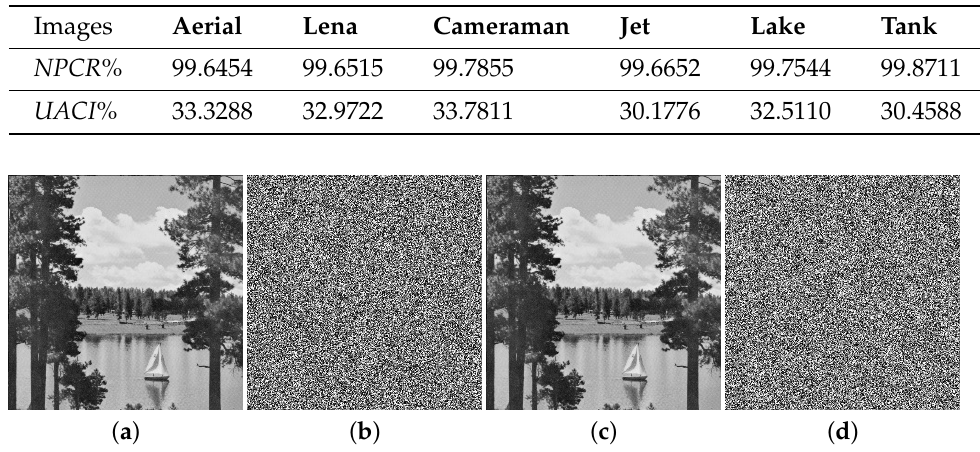
Table 4. Sensitivity to differential attacks— NPCR and UACI .